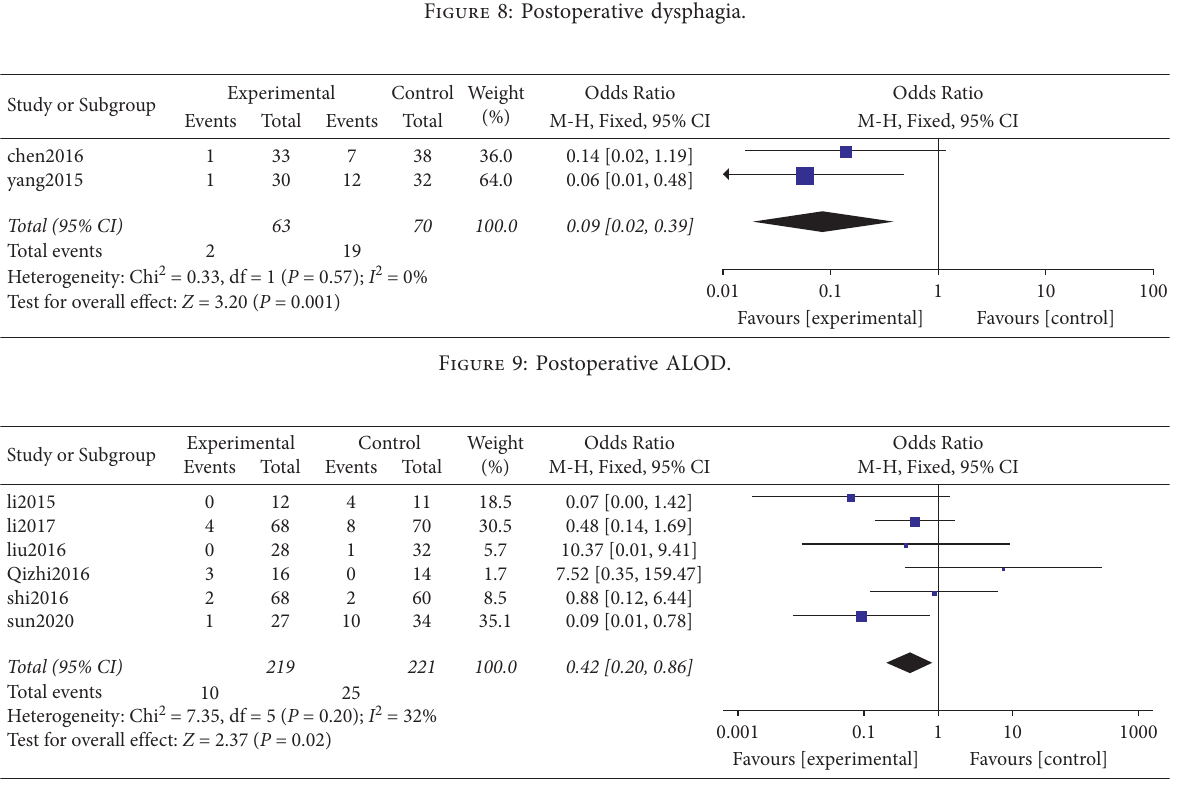
Figure 10: Postoperative